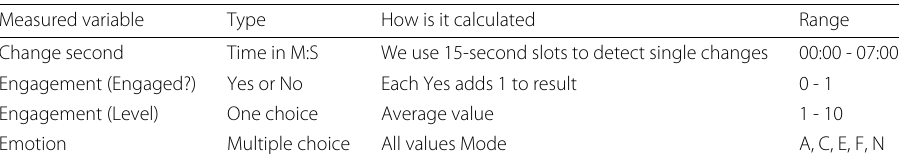
Table 2 Experiment